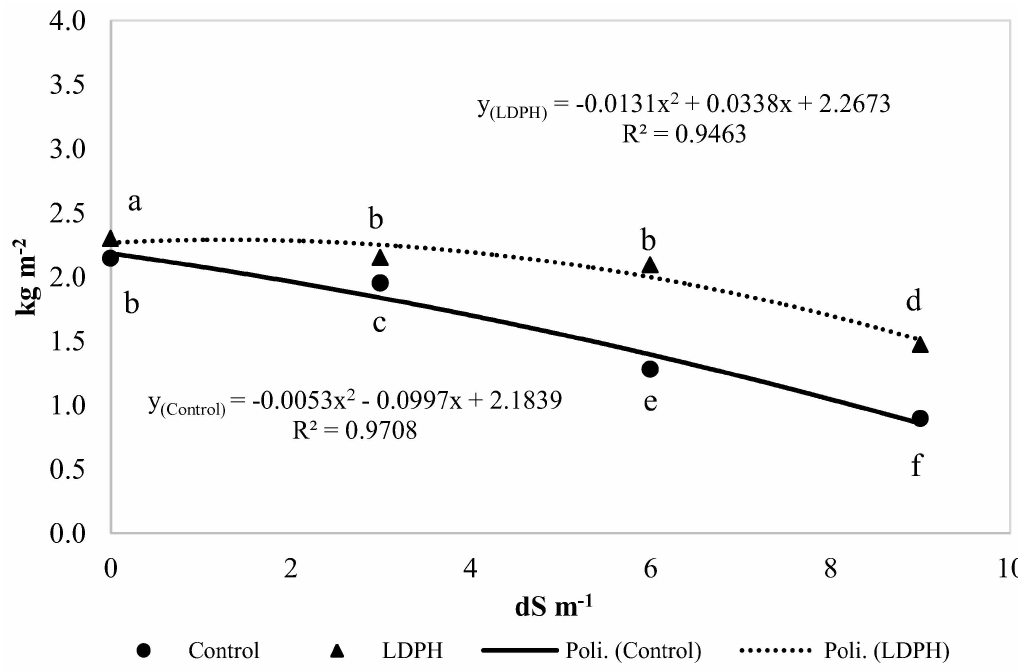
Figure 2. Spinach yield as affected by water salinity and biostimulant application. Different letters indicate statistical difference according to Tukey’s HSD test ( p ≤